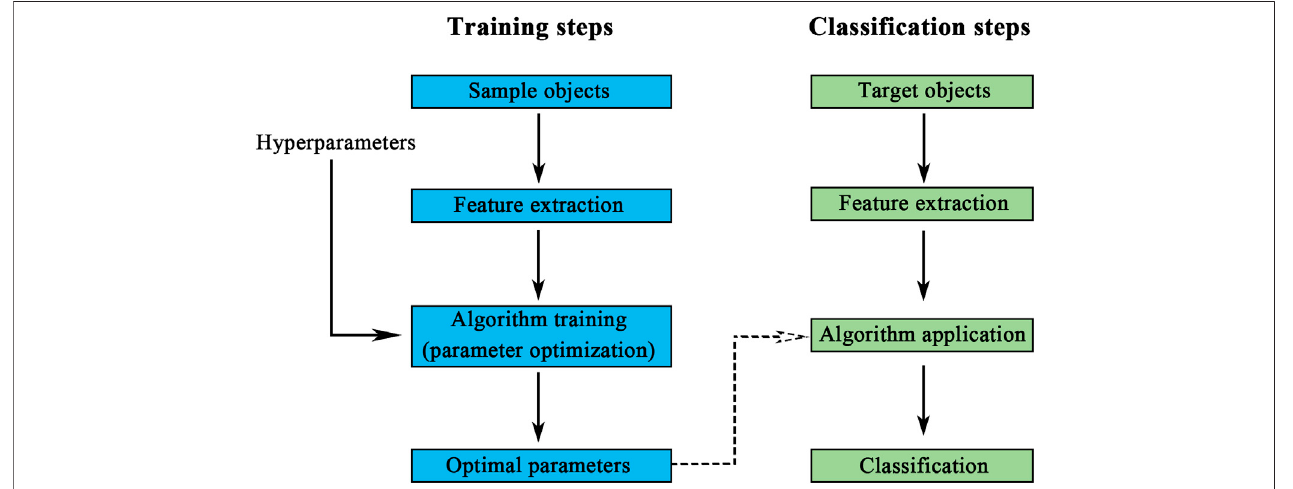
FIGURE 4 | Training and classi fi cation steps for machine learning algorithms.